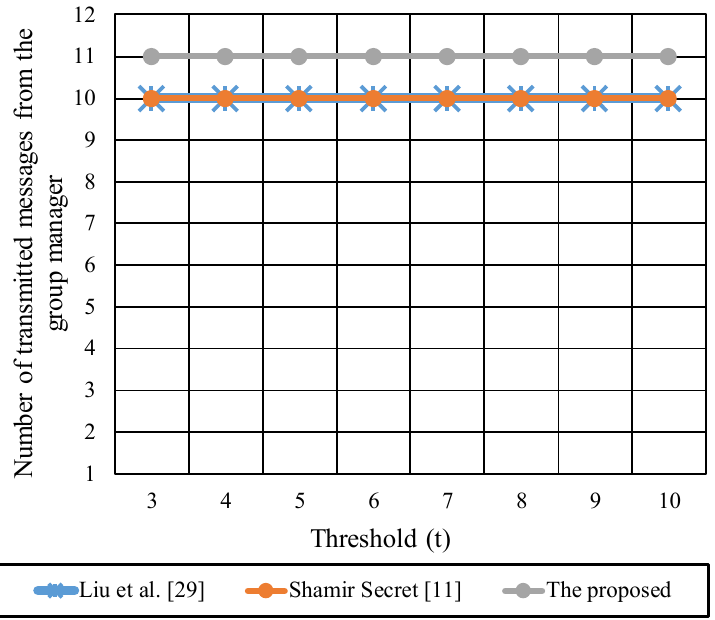
Figure 10. The total transmitted messages from the group manager during the key generation and reconstruction phases.